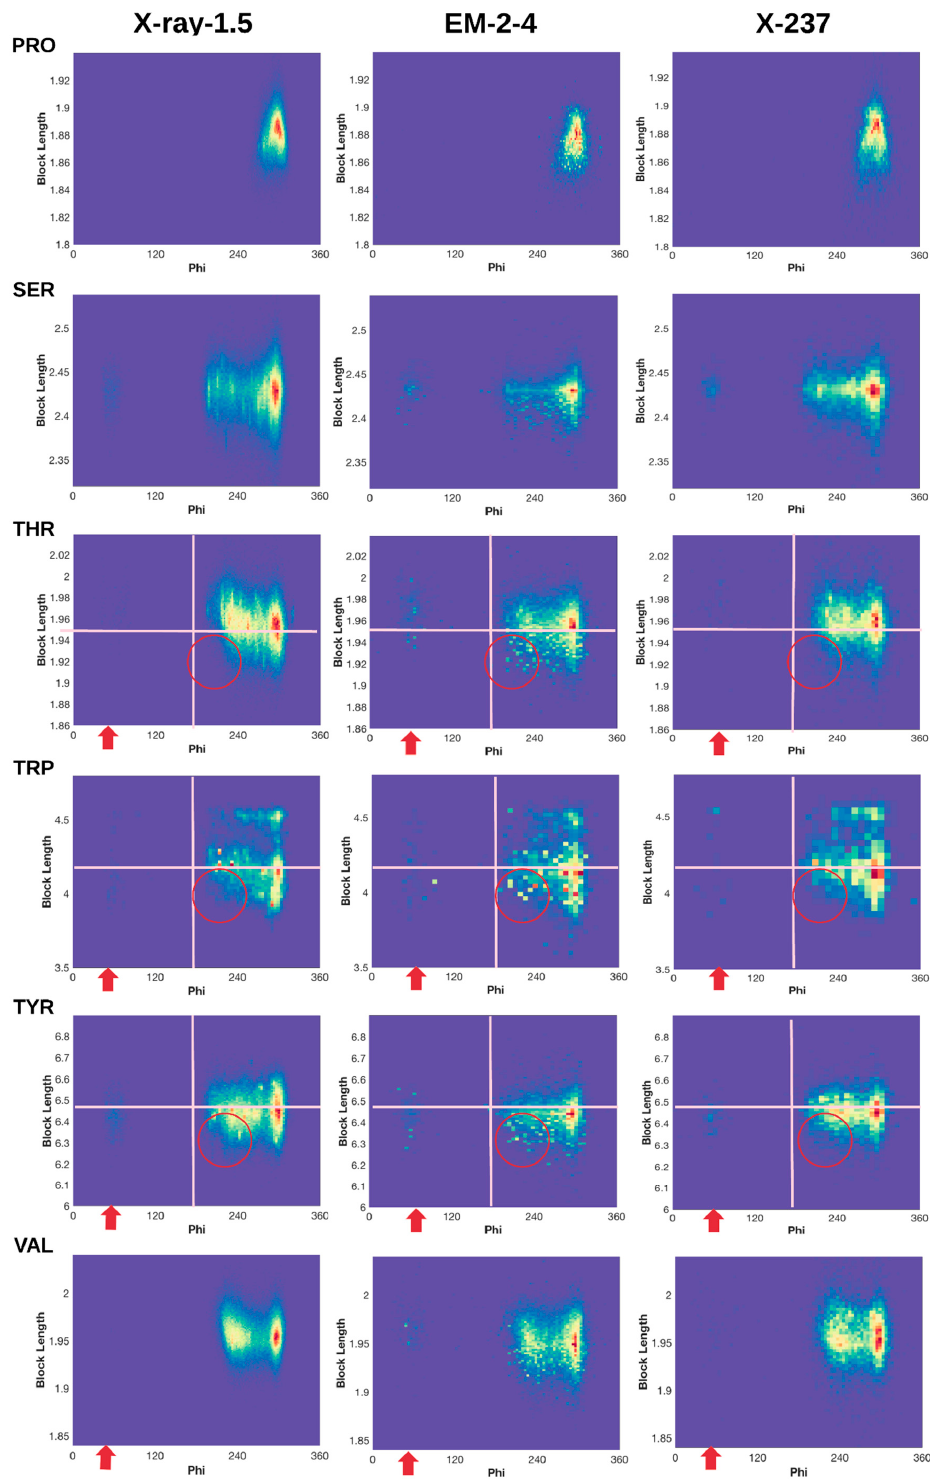
Figure 3. Normalized 2D histogram of ( φ , d Block ) for 18 residue types (Alanine (ALA) and Glycine (GLY) not included). Normalized 2D histograms of X-ray-1.5 data set (left column), EM-2-4 data set (middle column), and X-ray-237 data set (right column) were plotted using the ndhist function of MATLAB such that the most popular ( φ , d Block ) is colored red and the least popular is in dark blue [41]. Visually observed difference regions are labeled with red arrows and circles. Cross lines are drawn to assist